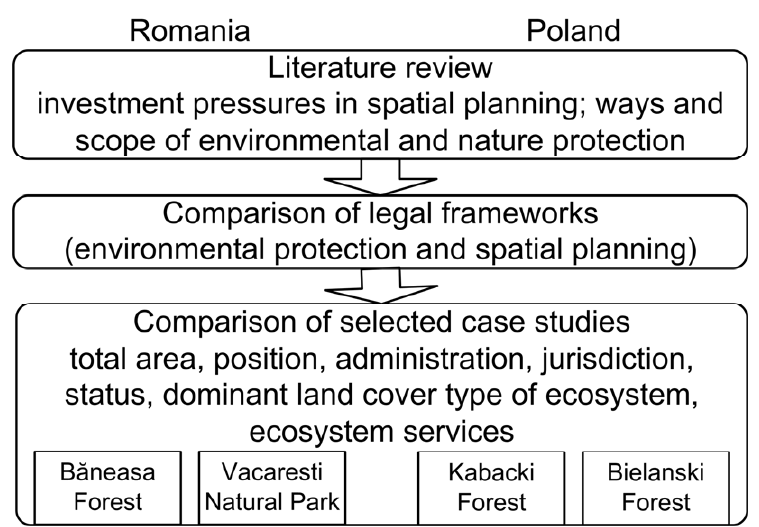
Figure 1. Phases of the methodology used in the present